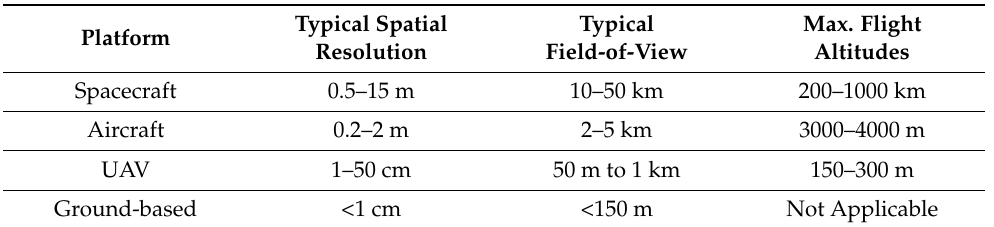
Table 1. Typical spatial resolution, fields-of-view, and maximum flight altitudes of remote sensing, close-range and ground-based platforms. Typical Spatial Typical Max. Flight Platform Resolution Field-of-View Altitudes Spacecraft 0.5–15 m 10–50 km 200–1000 km Aircraft 0.2–2 m 2–5 km 3000–4000 m UAV 1–50 cm 50 m to 1 km 150–300 m Ground-based <1 cm <150 m Not